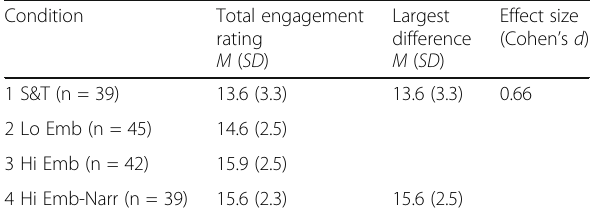
Table 5 Engagement means and SDs Condition Total engagement